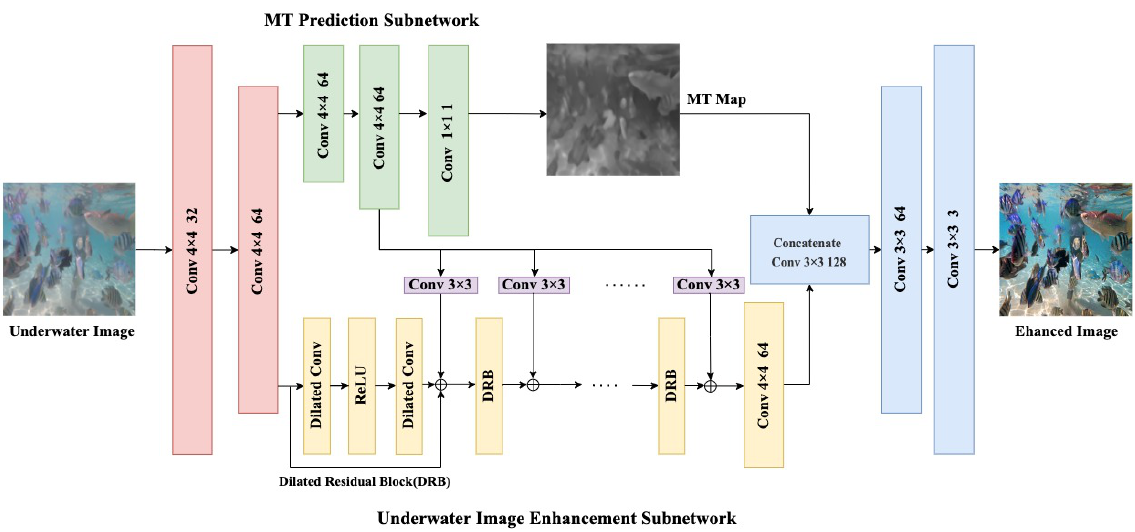
Figure 2. Schematic diagram of MTUR-Net. It consists of an encoder–decoder network for predicting the MT map (green), a set of dilated residual blocks (yellow) to generate local features, a convolutional layer (purple) for processing MT features before fusion, and the convolutional layer (blue part) to upsample the feature map and generate the underwater enhanced images. ⊕ pixel-wise